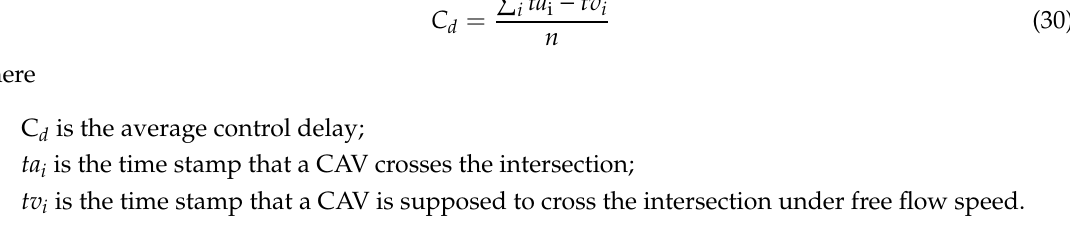
Figure 4. Optimal CAV trajectories for the decentralized control algorithm under different initial following headways.